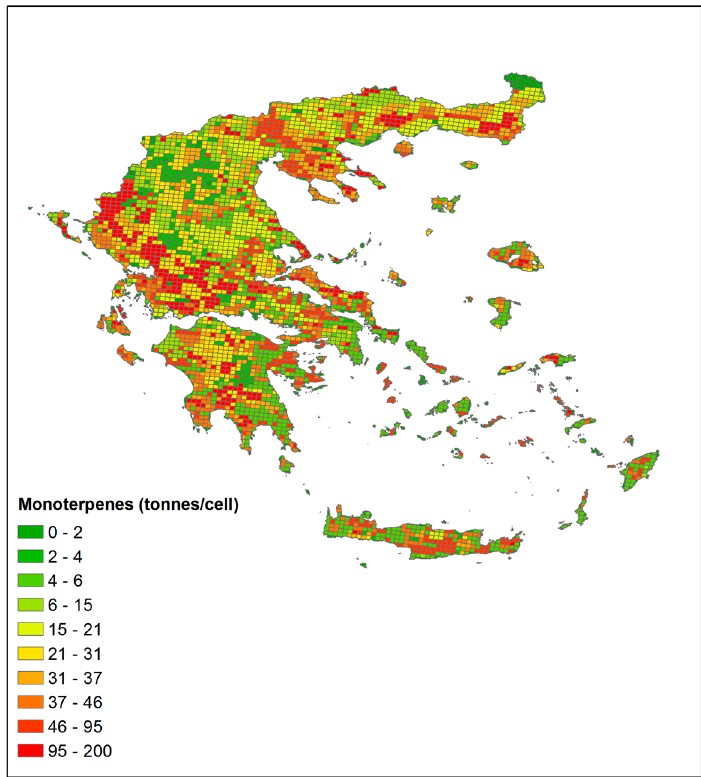
Figure 4. Spatial distribution of total monoterpene emissions over Greece.